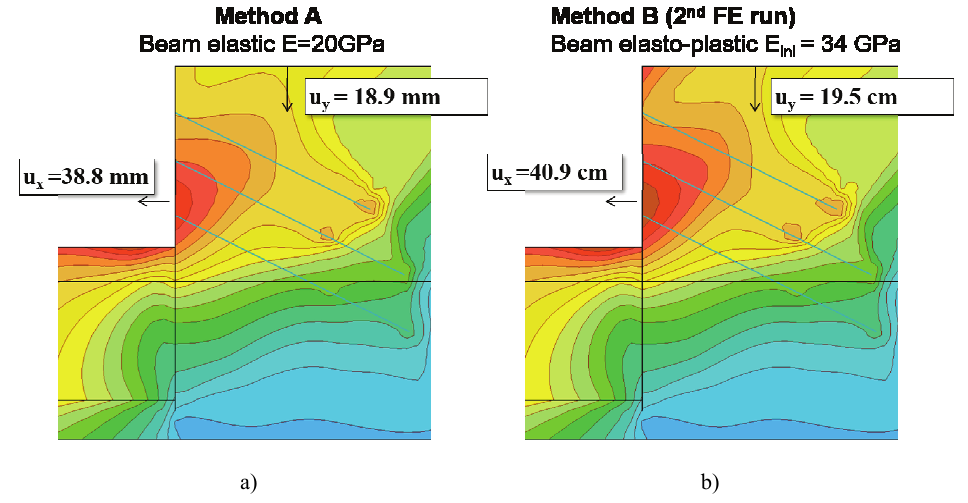
Fig. 9. Comparison of displacement fields obtained with (a) the elastic beam model (Method A),